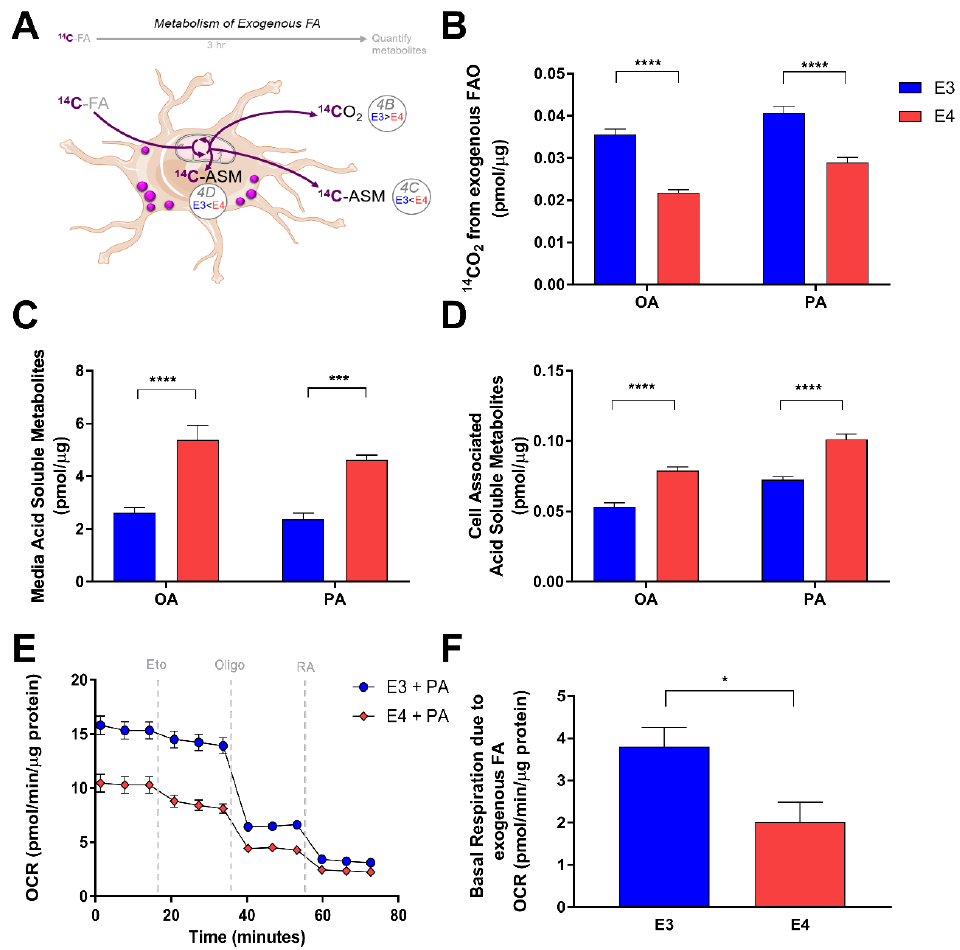
Figure 4. E4 astrocytes oxidize less exogenously supplied fatty acids. ( A ) Schematic and summary of pulse experiment to determine oxidation of exogenously supplied fatty acids. ( B ) E3 and E4 astrocytes were treated with [1- 14 C] oleate (OA) or [1- 14 C] palmitate (PA) and oxidation was measured over 3 h by a CO 2 trap assay. Acid soluble metabolites were quantified in media ( C ) and intracellular ( D ) fractions. Values represent mean +/ − SEM ( n = 6). Data were analyzed by t -test;*** p < 0.001, **** p < 0.0001. ( E ) E3 and E4 astrocytes were pretreated for 1 h with palmitate and subjected to a Seahorse Extracellular Flux Fatty Acid Oxidation Assay. Vertical gray dashes indicate time points of pharmacological injections of etomoxir (Eto), oligomycin (Oligo), or Rotenone and Antimycin (RA). ( F ) Oxygen consumption due to FA oxidation of exogenously supplied palmitate was determined (see methods) and graphed. Values represent means +/ − SEM ( n = 3–4). Data were analyzed by unpaired t -test; * p < 0.05.